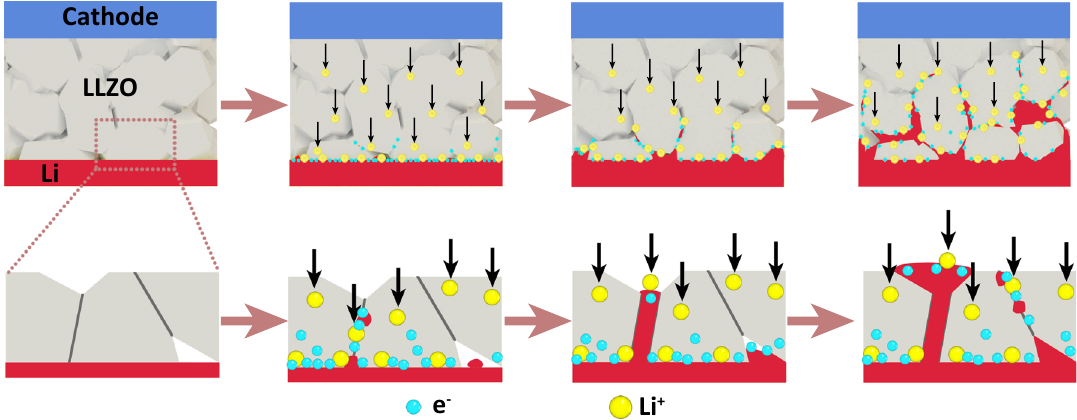
Fig.7 |ProposedmechanismforLidendritenucleationandgrowthinall-solid- state asymmetric Li metal cells. With time increasing, lithium dendrites